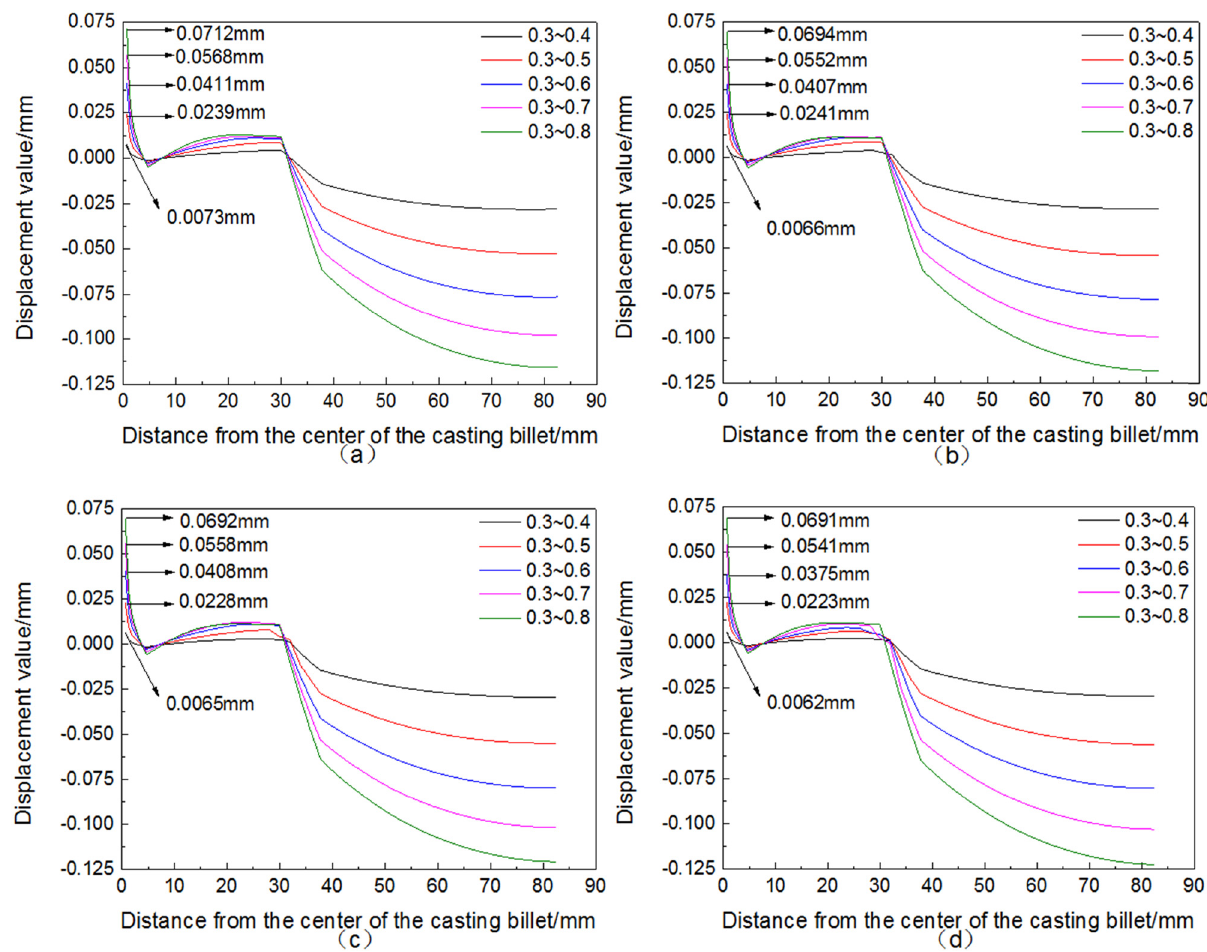
Figure 7: Displacement under di ff erent superheat: ( a ) 10°C, ( b ) 20°C, ( c ) 30°C, and ( d ) 40°C.